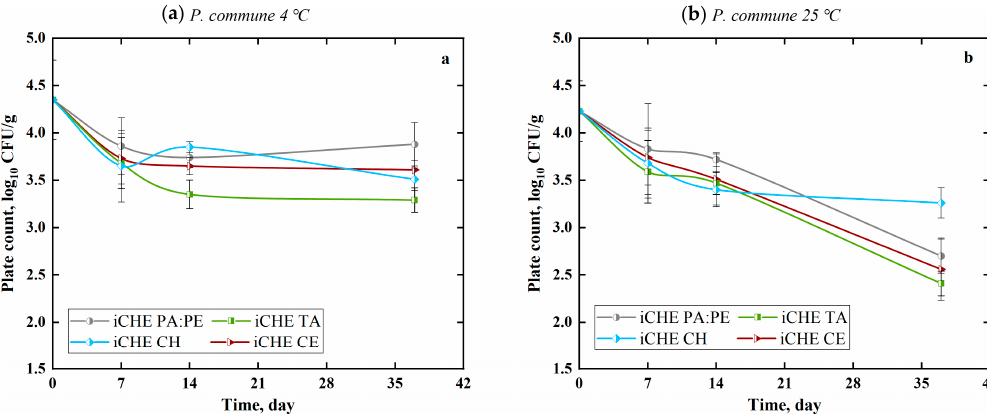
Figure 2. The effect of biopolymer films (CH, TA:CH, CE:CH) on P. commune count on cheese during storage at: ( a ) 4 °C and ( b ) 25 °C. Values are means ( n = 2 × 2) with standard errors that are significantly different within columns ( p < 0.05; Table S1).